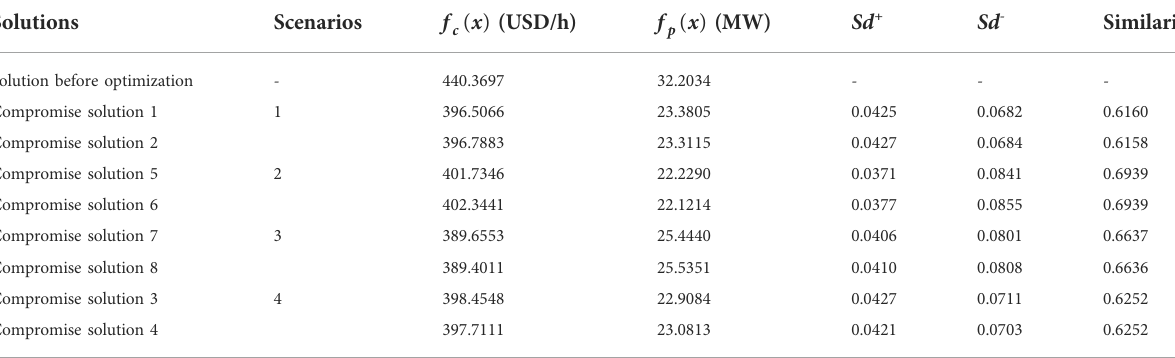
TABLE 9 Comparison of compromise solutions and the solution before